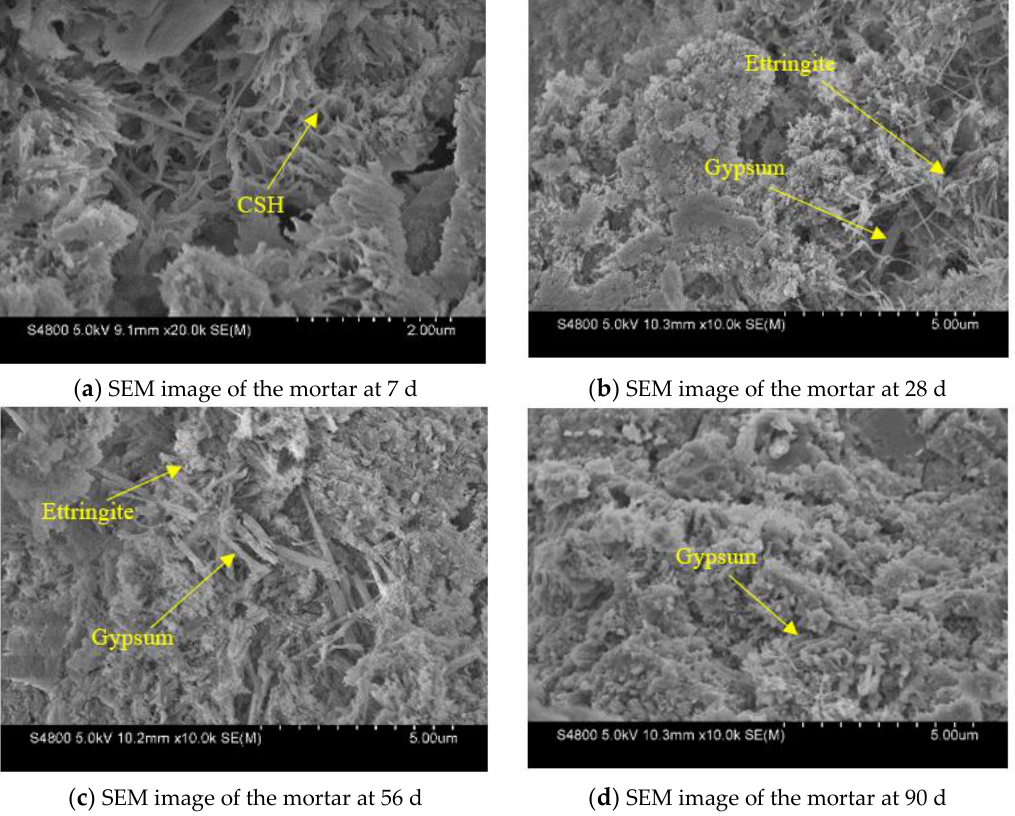
Figure 7. SEM images of the mortar.